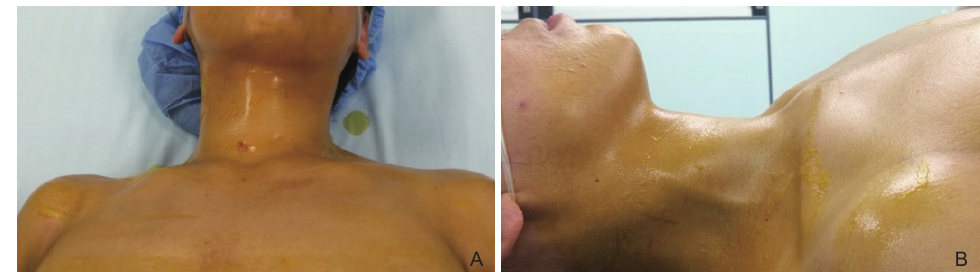
Figure 8 Skin disinfection area. (A) The upper and lower edges of disinfection area; (B) The lateral edge of disinfection area.